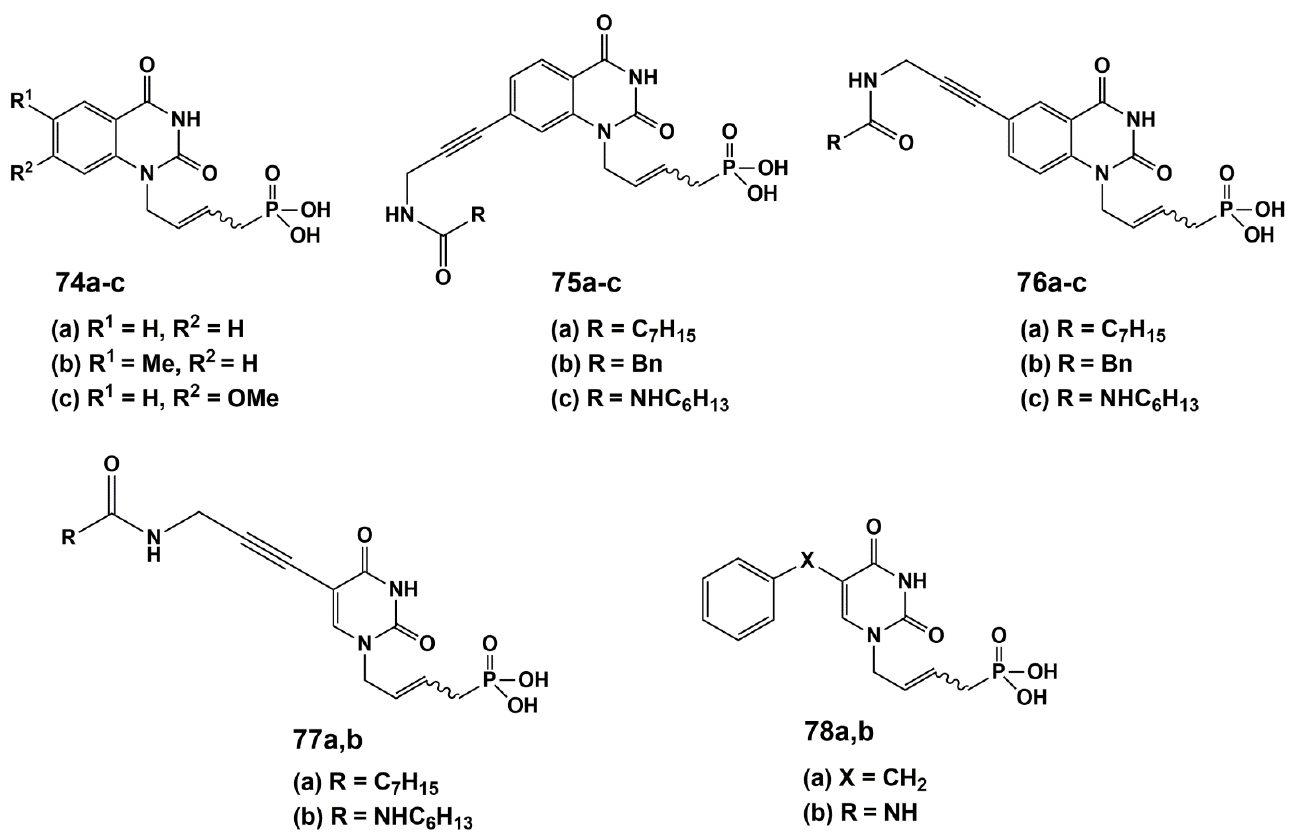
Figure 20. Structures of acyclic nucleoside analogues’ phosphonates—inhibitors of ThyX. Twelve analogues of acyclic nucleoside phosphonates were synthesized and tested for their activity against Mtb ThyX. These phosphonates were 5- and 7-substituted quinazoline and 5-substituted uracil linked at N1 to a (E)-but-2-enyl phosphonic acid moiety.